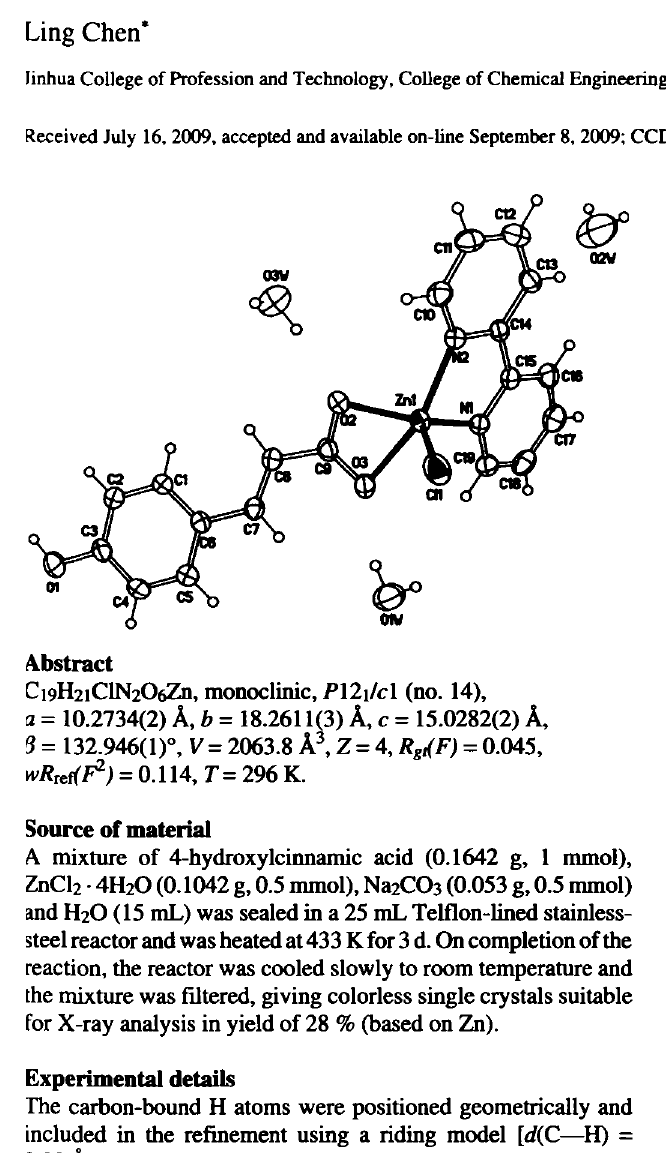
Table 2. Atomic coordinates and displacement parameters (in Â 2